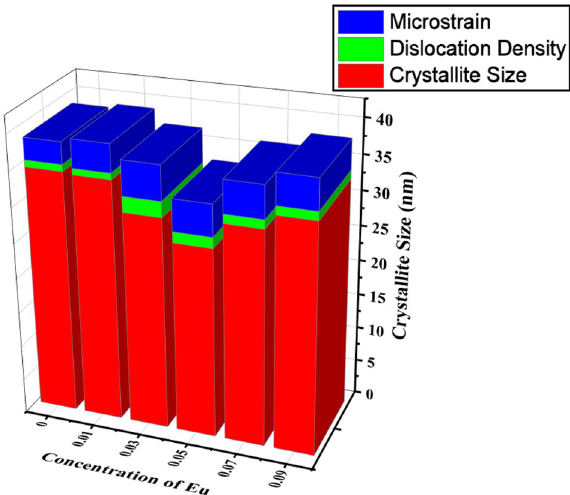
Figure 3. Variation of Microstrain, Dislocation Density and Crystallite Size with Concentration of Eu for Sr 1−x Al 2 O 4 :Eu x (x = 0.00, 0.01, 0.03, 0.05, 0.07, and 0.09) phosphor (SAE